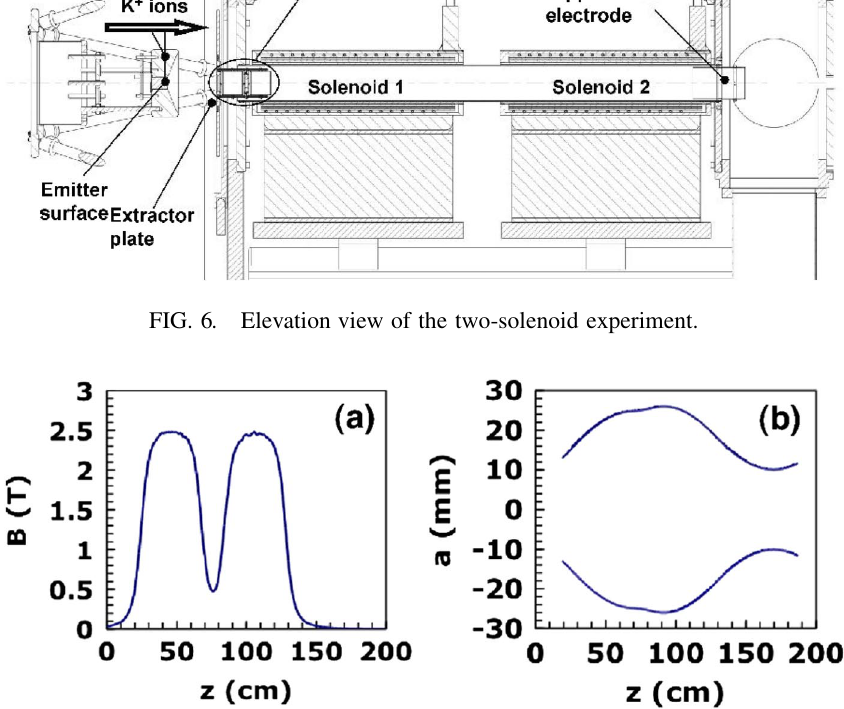
FIG. 7. (Color) (a) Axial magnetic field profile based on measurements; (b) calculated beam